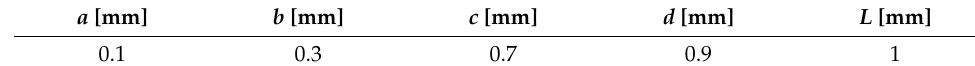
Table 1. Geometric parameters, as in Figure 1a, defining the Swiss-cross holes unit cell.